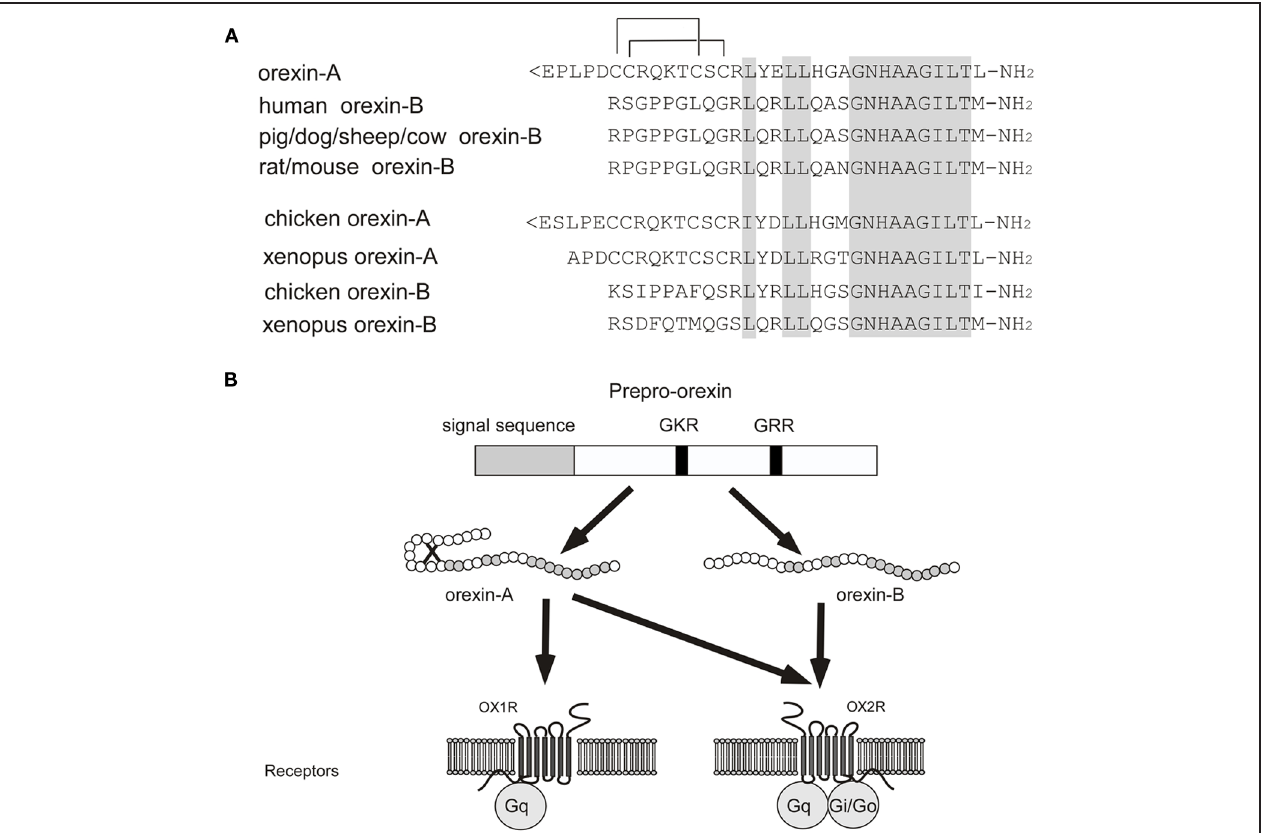
FIGURE 1 | Orexin and orexin receptors. (A) Structure of mature orexin A and orexin B peptides. The topology of the two intrachain-bonds in orexin A is indicated above the sequence. Amino acid identities are indicated by shading . Mammalian orexin A sequences thus far identified (human, rat, mouse, pig, dog, sheep, and cow) are all identical, while the sequences of orexin B show some differences among species. (B) Schematic representation of orexin